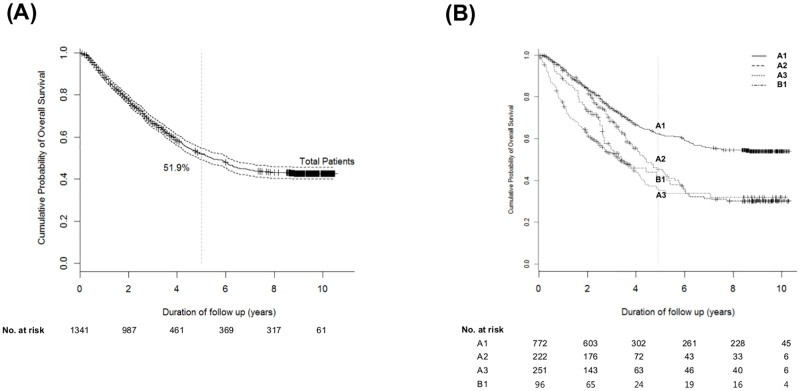
Cumulative overall survival rate of patients with BCLC A or B1.(A) Cumulative overall survival rate of patients with BCLC A or B1 (B) Respective cumulative overall survival rates of patients with BCLC A1, A2, A3 and B1.